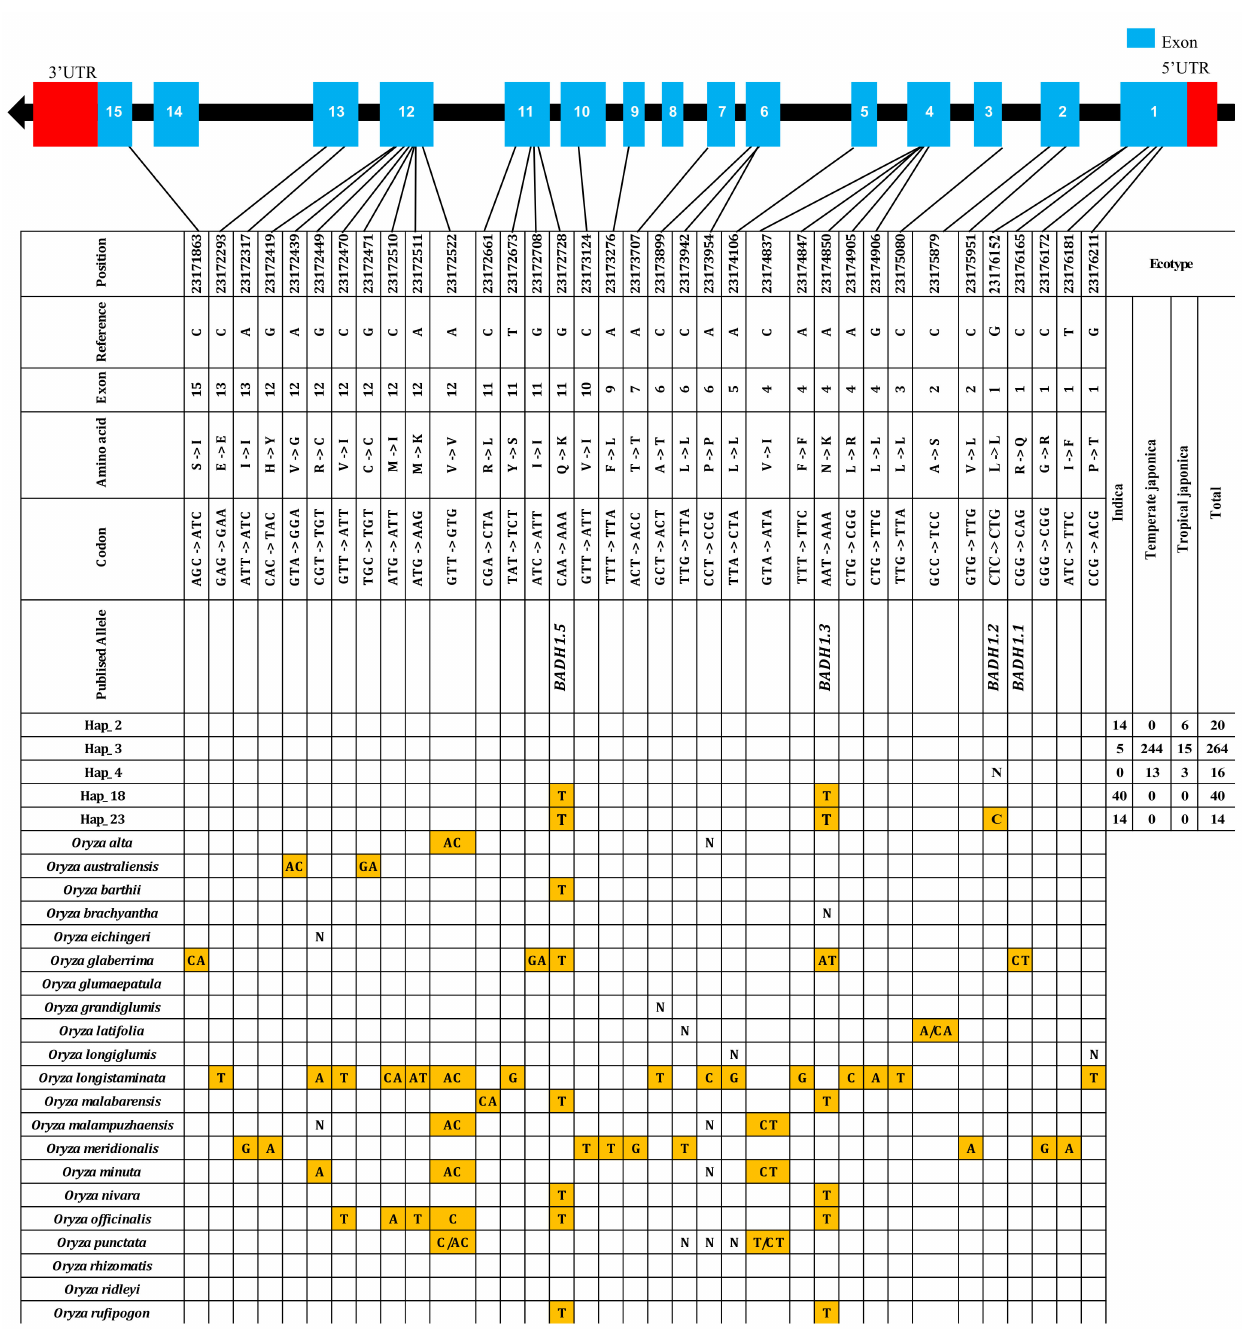
Figure 4. Gene structure and haplotype analysis of BADH1 ( Os04g0464200 ) in gene-coding regions of selected cultivated rice and all wild species. The five cultivated haplotypes representing the highest number of rice accessions were selected, and their genetic association was investigated by SNPs or InDels in wild rice. Here, we used one wild rice accession as a haplotype. Orange-colored SNPs indicate all identified SNPs observed as nonsynonymous and synonymous substitu- tions. Blank cells refer to the same nucleotide mentioned in reference. “N” indicates the positions of unknown nucleotides. The two-digit number indicated under ecotype (Indica, Temperate Japonica, and Tropical Japonica) refers to the number of rice accessions identified in each